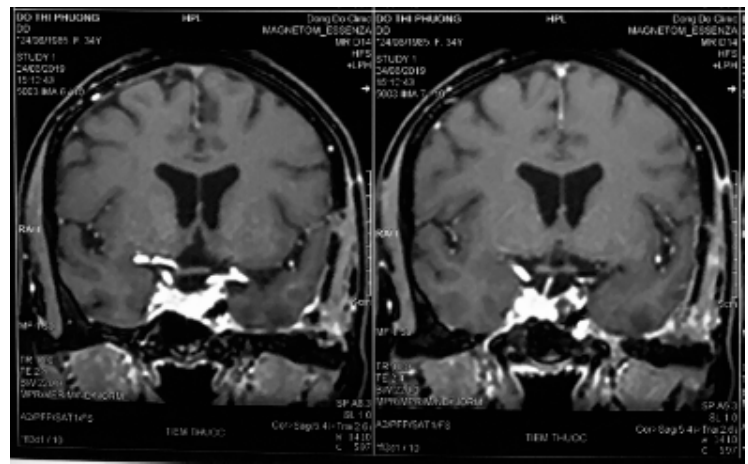
Figure 4. Three-month postoperative magnetic resonance imaging.